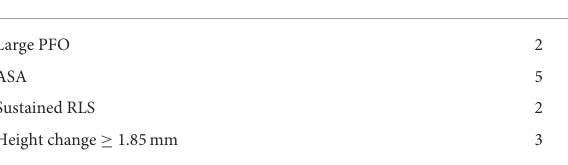
TABLE 5 A calculator for CS prediction based on OR